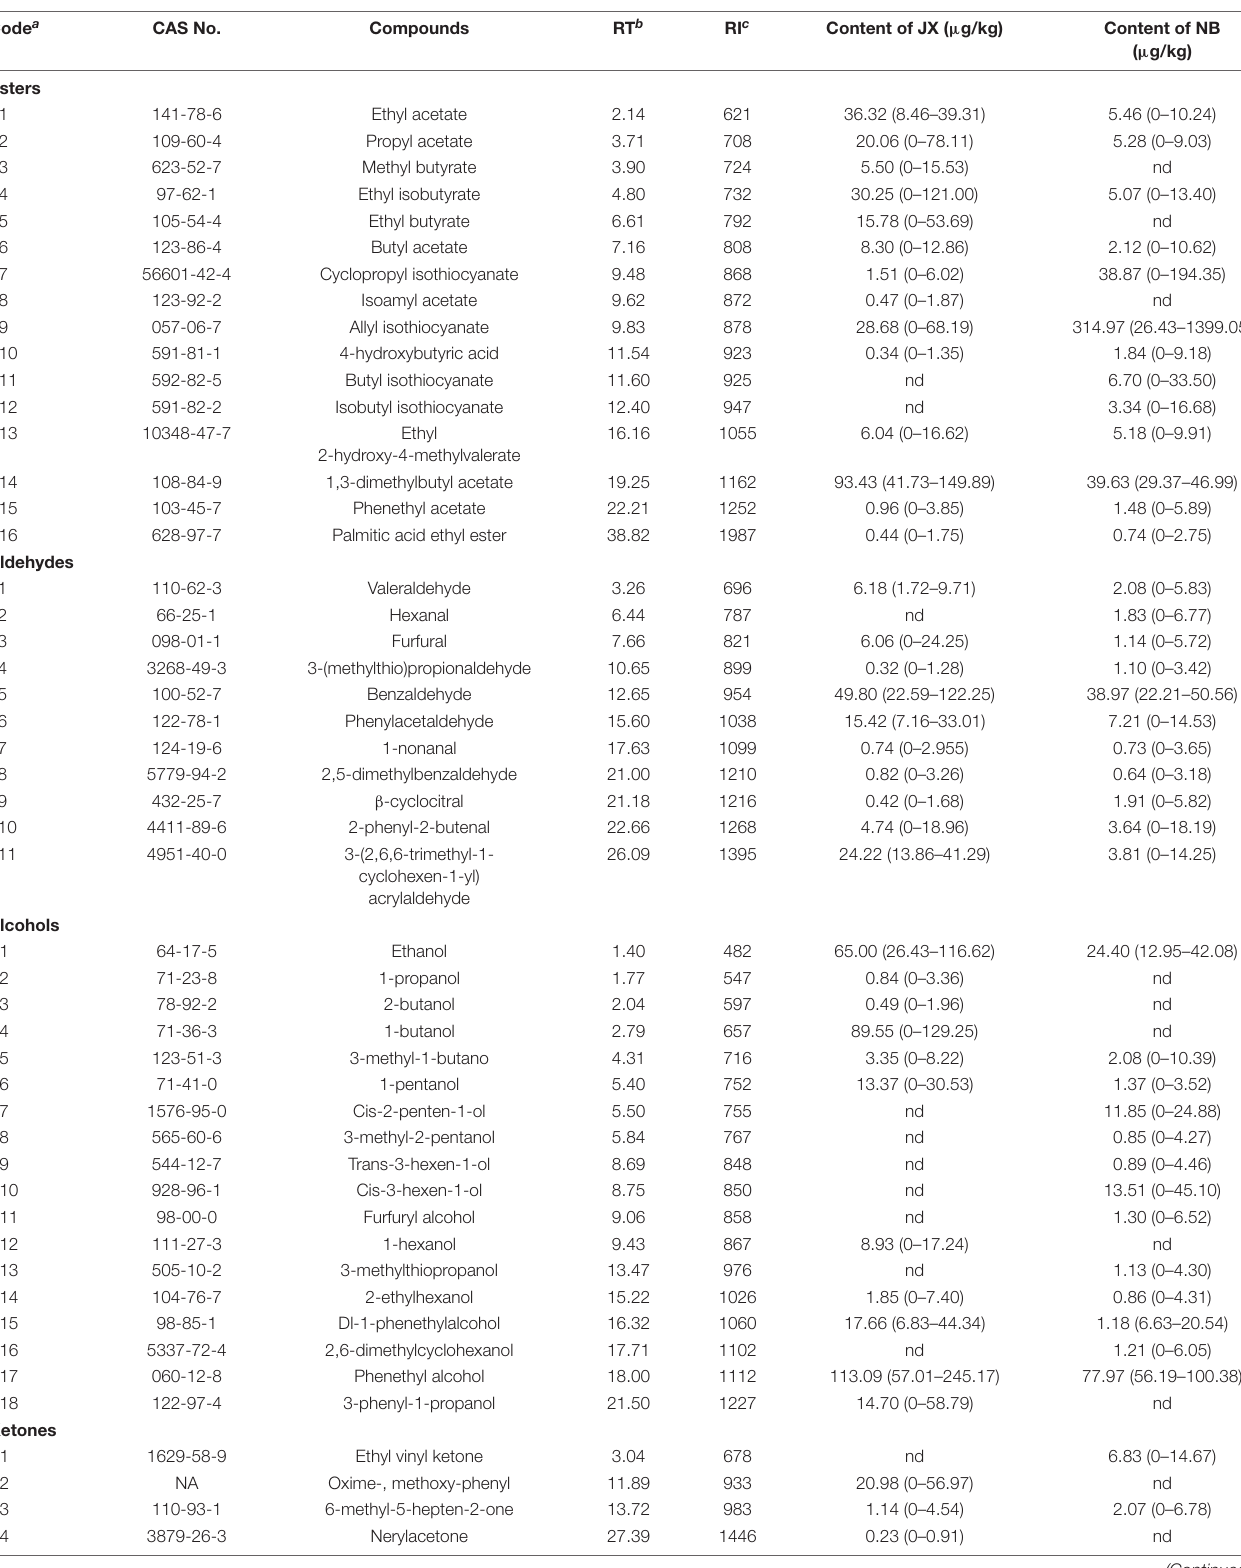
TABLE 2 | Average contents of esters, aldehydes, alcohols, ketones, acids, nitriles, alkenes, phenols, others, and their distribution ranges (in parenthesis) in traditional fermentation Xuecai (JX), and modern fermentation Xuecai (NB). Code